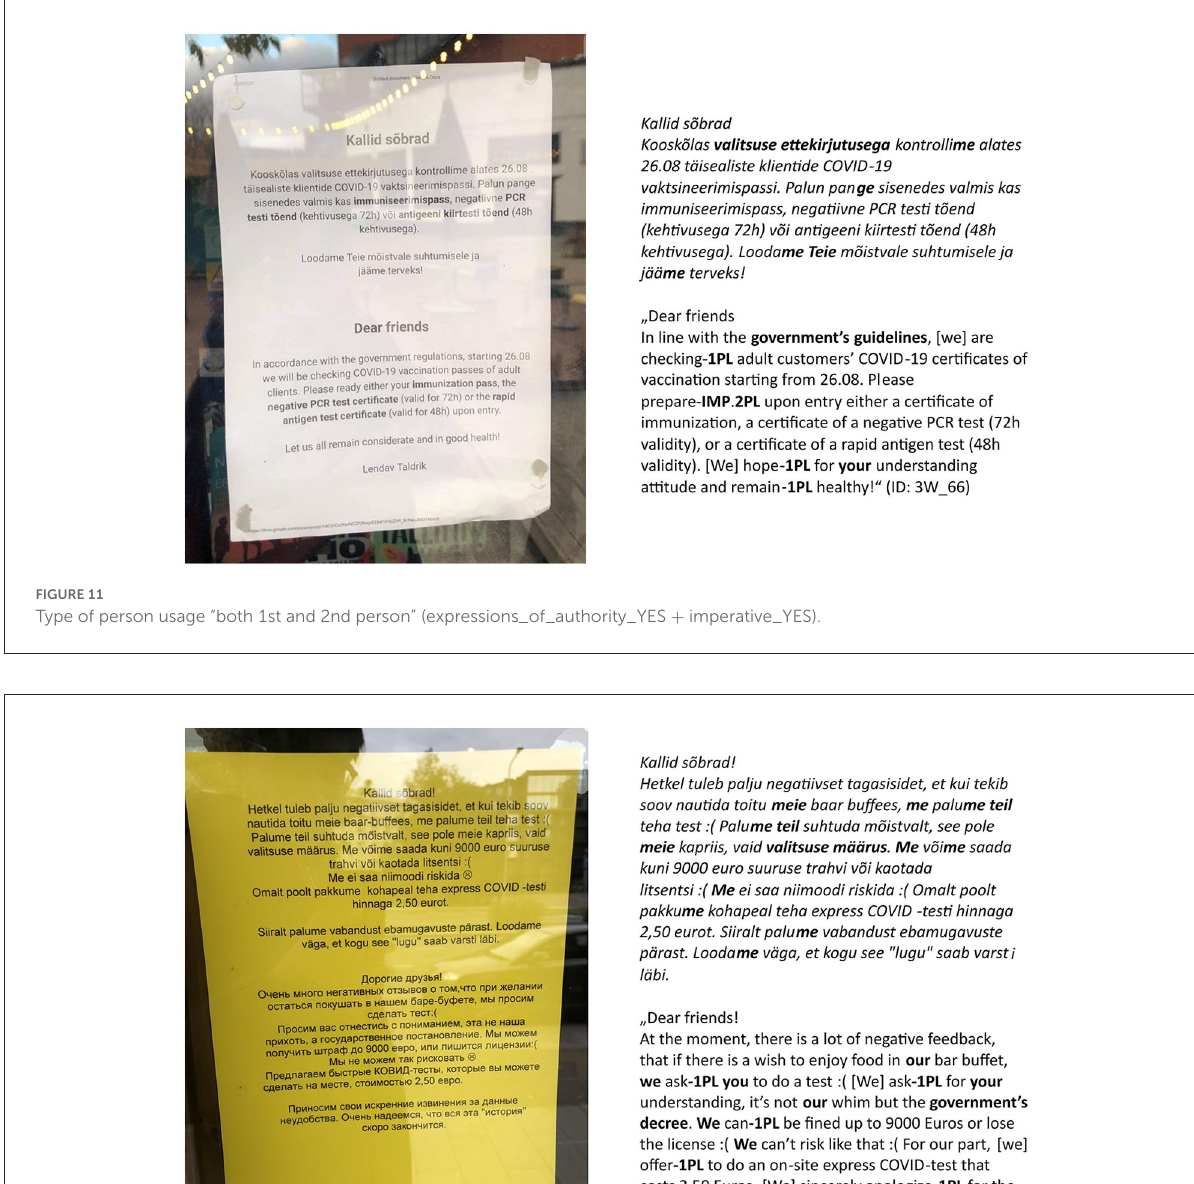
In everyday conversations, using the imperative mood in 2nd person is a natural way to address the